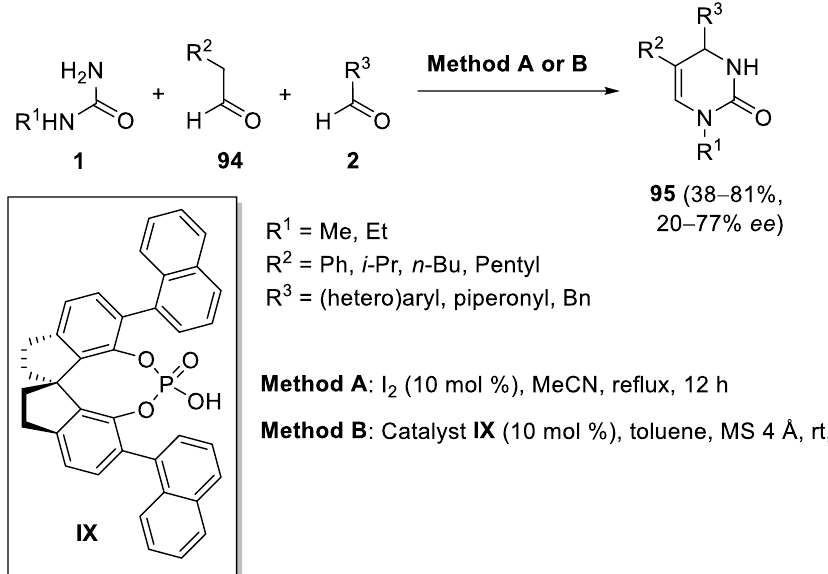
Scheme 44. Biginelli-type reaction of urea, alkyl aldehydes 94 , and aryl aldehydes.